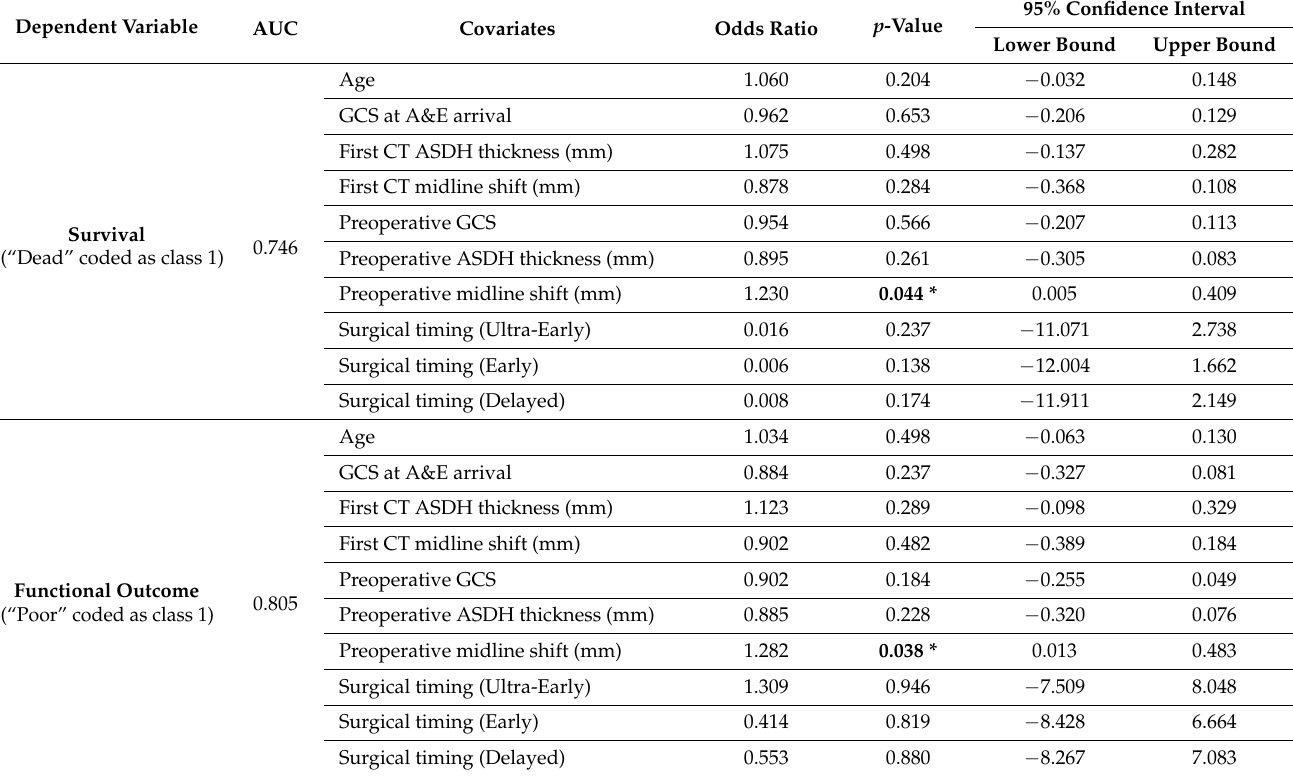
Table 3. Binomial logistic regression: analysis of variables associated to survival and functional